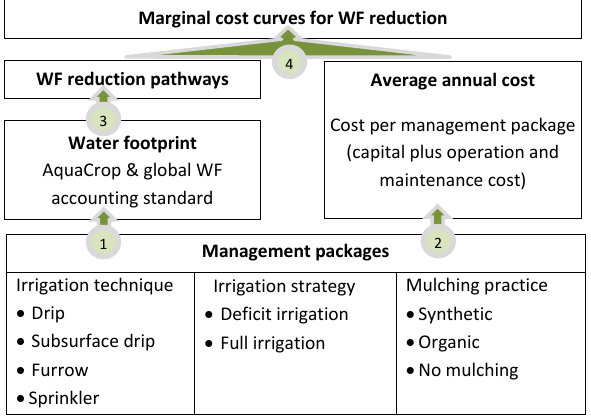
Figure 1. Flow chart for developing marginal cost curves for crop